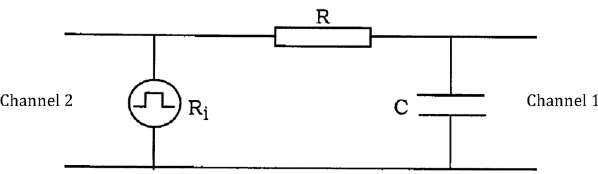
FIG. 2. The RC circuit diagram given in the laboratory exercise instruction featuring a function generator ( R ), the two channels i of an oscilloscope, a capacitor ( C ), and a resistor ( R ). (Note that resistors are sometimes drawn as a rectangle in Swedish physics textbooks.) Of this information only the labeling of the function FIG. 3. A coaxial cable with the black and red colored banana generator was explained in the laboratory instructions. plugs on the left and the BNC connector on the